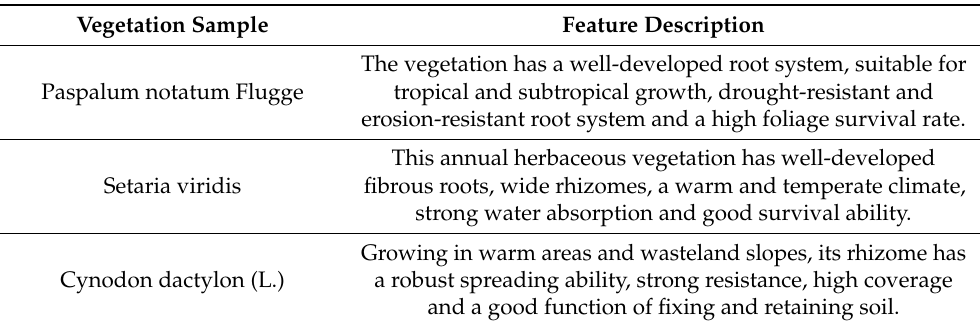
Table 1. Vegetation characteristics [19,20].(Reproduced or adapted from [19,20], with permission from Acta Agriculturae Universitatis Jiangxiensis and China University of Mining and Technology, Beijing, China, 2012, 2019.)